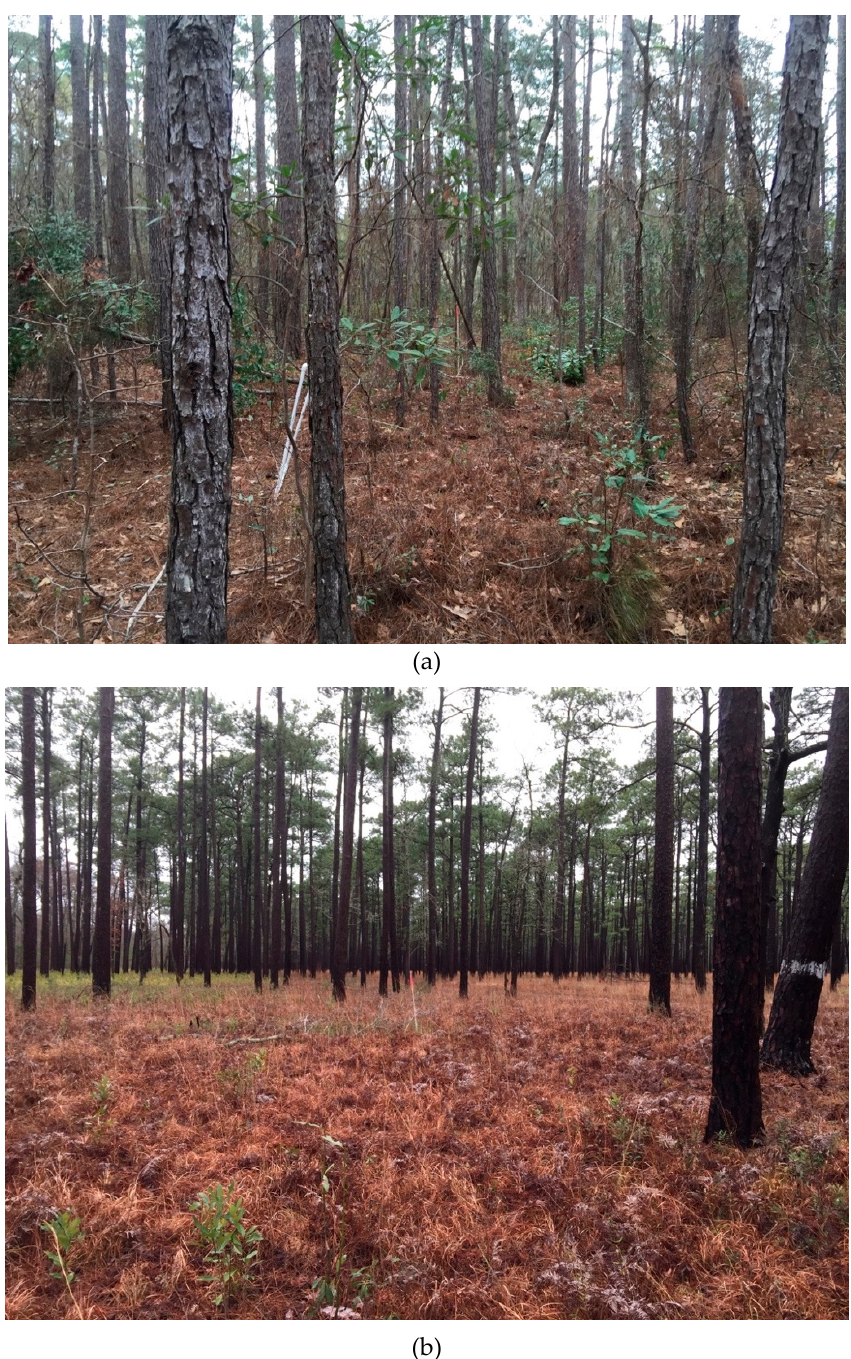
Figure 2. Representative photographs depicting conditions of the ( a ) long-term unburned compartment and ( b ) regularly burned compartments of the Tom Yawkey Wildlife Center, Georgetown, SC, USA in March 2015. The long-term unburned compartment was characterized by closed canopy conditions, higher stand density, and higher forest floor depth and mass. The regularly burned compartments were characterized by open canopy conditions, lower stand density, and lower forest floor depth and mass.